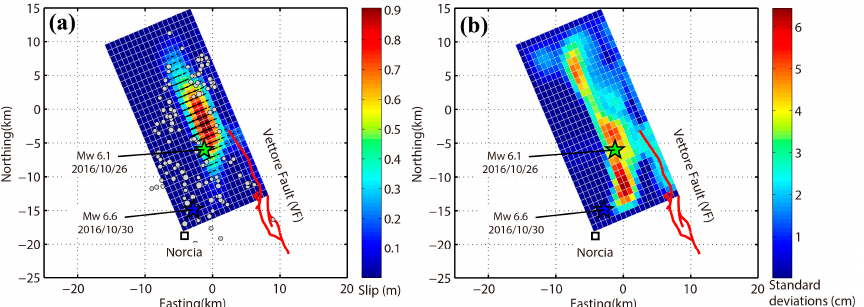
Figure 5. ( a ) Surface projection of the coseismic slip model of 26 October 2016 Visso earthquake. ( b ) Standard deviations in slip from Monte Carlo estimation with 100 perturbed datasets. Red lines represent the active fault. Gray dots denote the aftershocks of ML > 3 from 26 October to 29 October 2016 [12]. Color shows the slip magnitude in meters, and arrows correspond to the slip directions. White square denotes the city of Norcia. The green star denotes the epicenter of 26 October 2016 Visso earthquake, the blue star denotes the epicenter of 30 October 2016 Norcia earthquake [12].